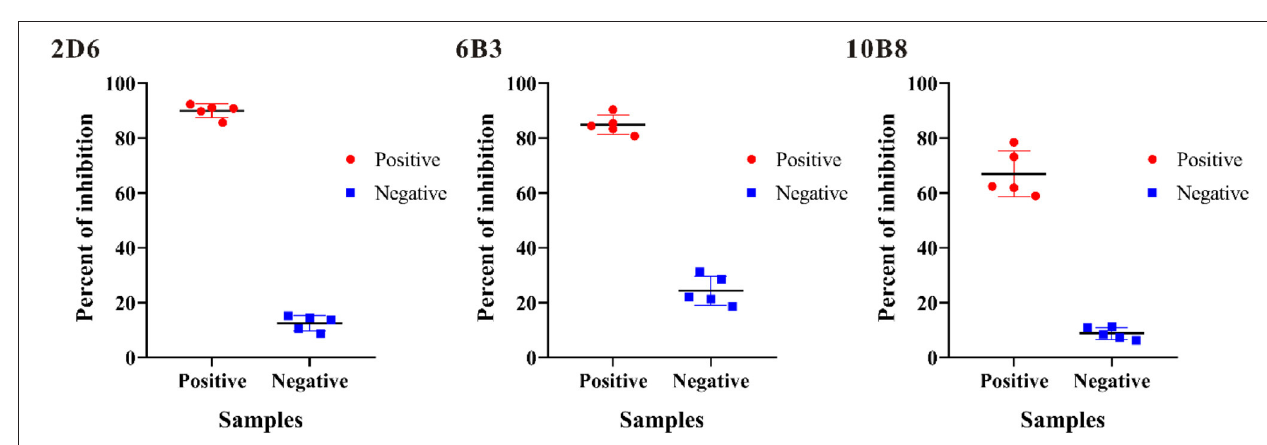
FIGURE 3 | Investigation of p30 monoclonal antibodies on blocking ELISA for ASF detection. The percent of inhibition of five positive samples (Red) and five negative samples (Blue) were determined, and the average percent of inhibition of negative and positive samples was displayed.